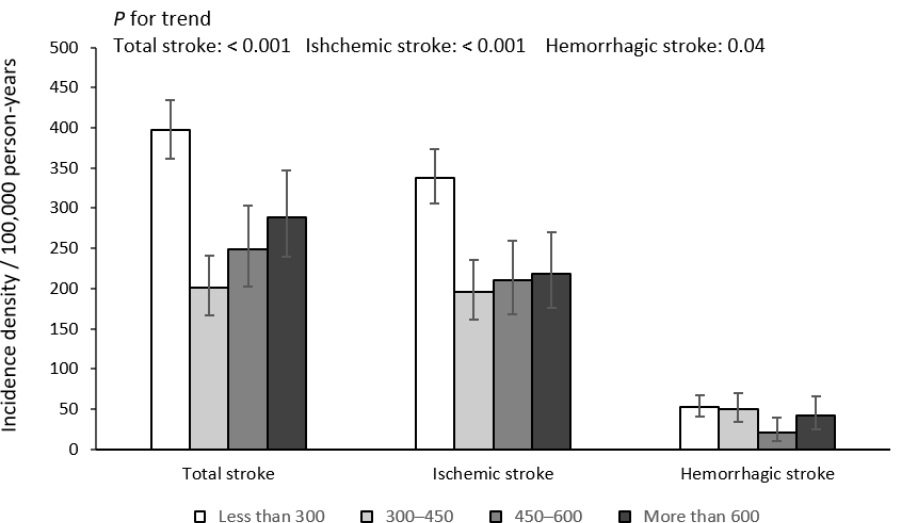
Figure 2. Incidence densities of total stroke, ischemic stroke and hemorrhagic stroke across four categories of fish consumption (g/week).